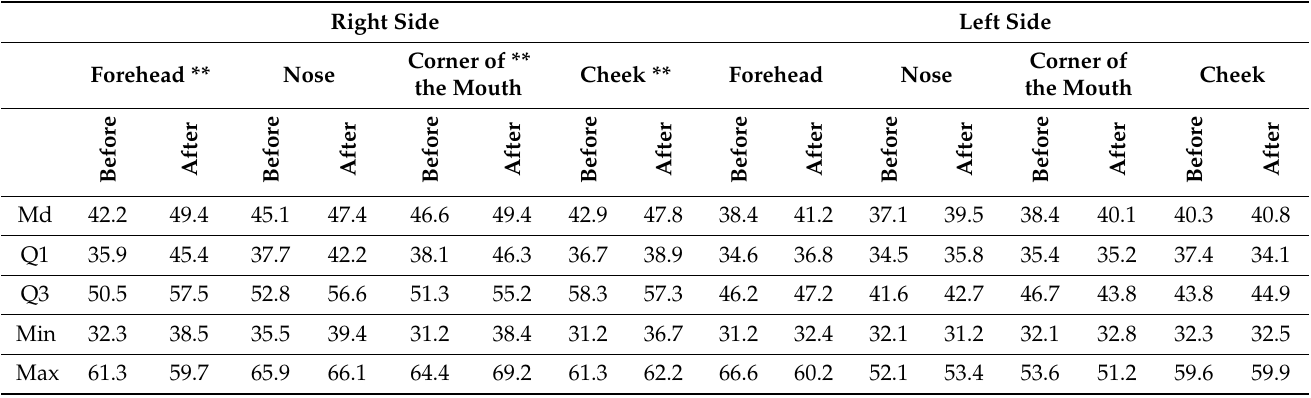
Figure 3. Moisturizing the skin in various areas of the face on the right side, treated with microder- mabrasion and pyruvic acid, and on the left side, treated only with acid before and after treatments, ** p < 0.01. Table 4. Moisturizing the skin in various areas of the face on the right side, treated with microder- mabrasion and pyruvic acid, and on the left side, treated only with acid before and after treatments, ** p < 0.01, Md—Median, Q1—1st quartile, Q3—3rd quartile, Min—Minimum, Max—Maximum. Right Side Left